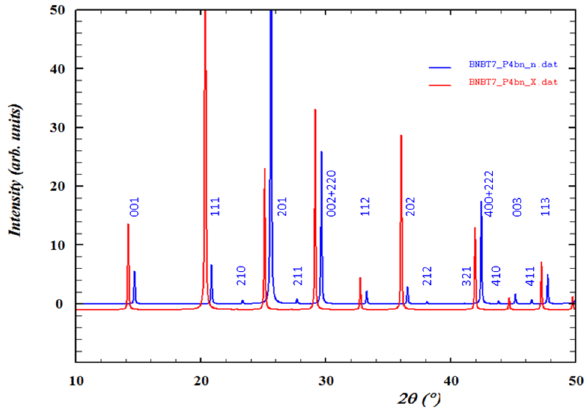
Figure 19. X ‐ ray (red) and neutron (blue) diffraction patterns for tetragonal P 4 bm BNBT. Wavelength: 1 Å. Tetragonal indexing of peaks. Indexes in the lower level correspond to superlattice reflections.